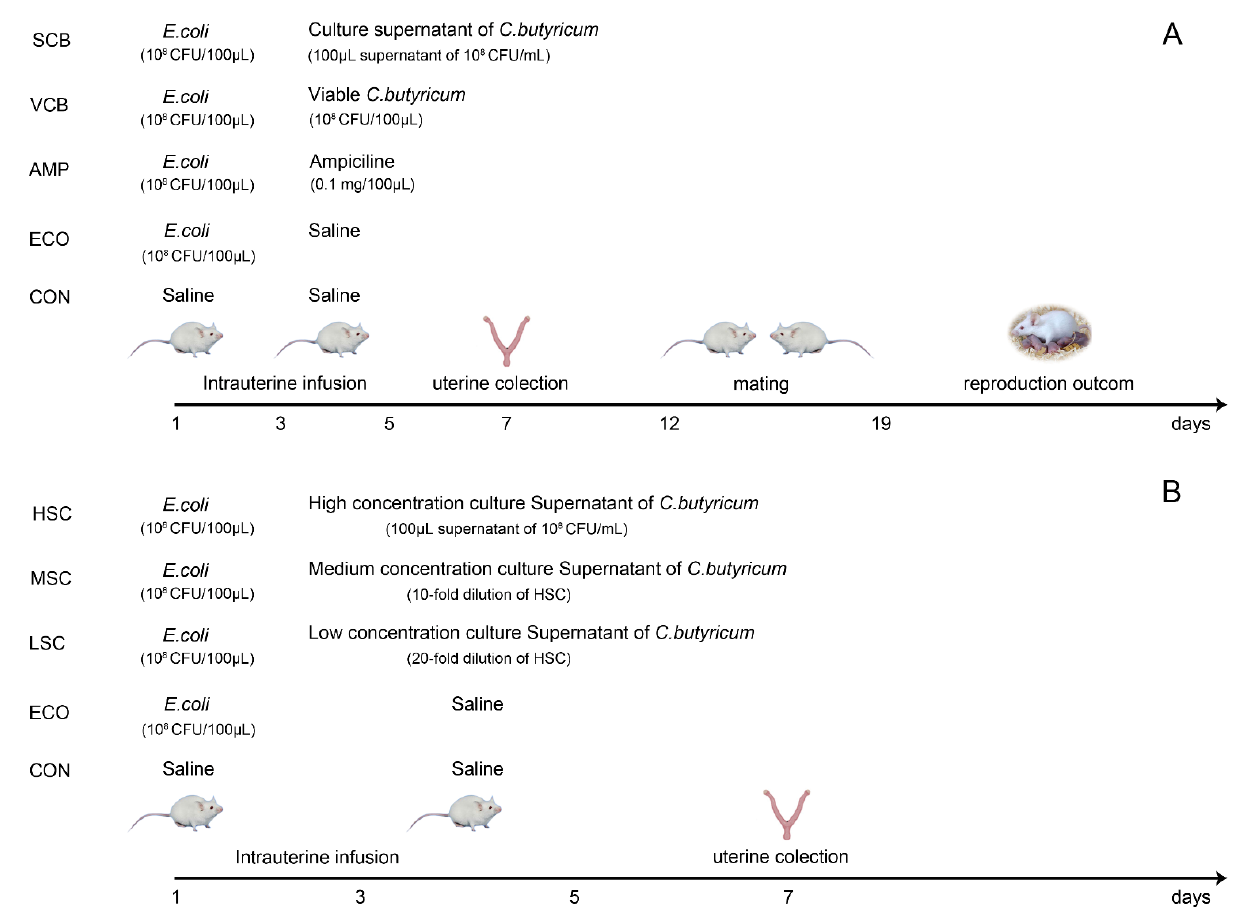
Figure 1. Timeline of animal experiments. ( A ) Experimental design of the effect of C. butyricum and its culture supernatant on E. coli -induced endometritis in mice. ( B ) Experimental design of the effect of different concentrations of C. butyricum culture supernatant on E. coli -induced endometritis in mice.